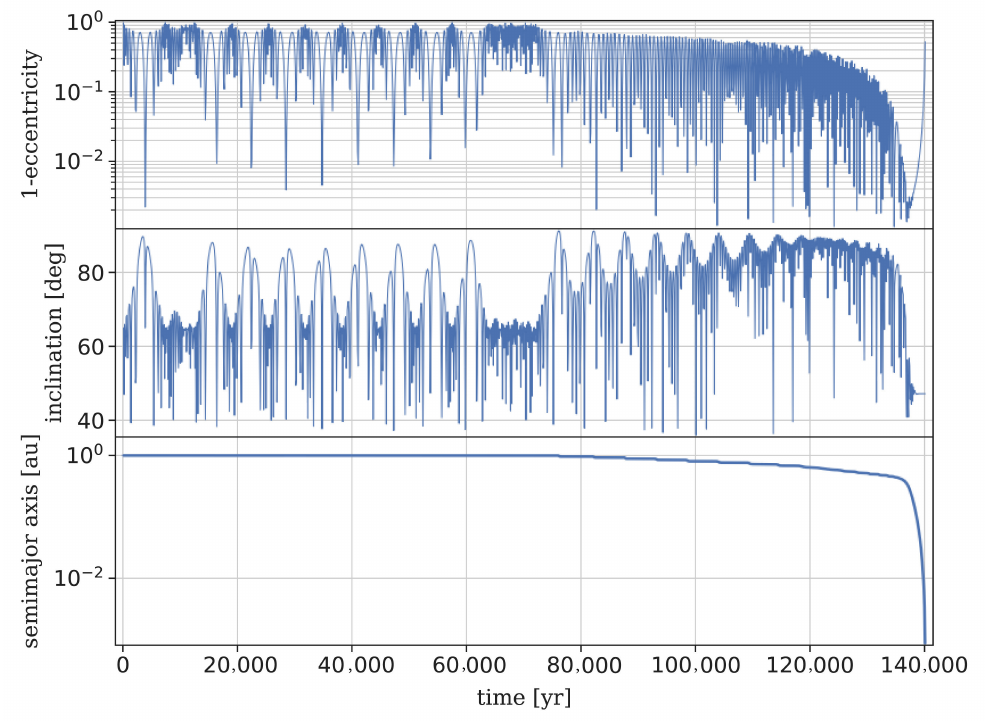
Figure 10. Gravitational-wave merger induced by von Zeipel-Kozai-Lidov evolution in a triple system. Orbital parameters as a function of time for a triple system. Top panel: eccentricity of the inner orbit. Middle panel: inclination of the outer body’s orbit with respect to the inner binary. Bottom panel: semimajor axis of the inner binary. The initial orbital parameters of the triples are: mass of the outer body m 3 = 40M (cid:12) , mass of the inner bodies m 1 = 10M (cid:12) , m 2 = 20M (cid:12) , inner semimajor axis a 1 = 1 au, outer semimajor axis a 2 = 16 au, mutual inclination i mut = 65 ◦ . Evolved with OKINAMI , which solves the orbit-averaged equations of motion in Delaunay coordinates (Trani et al., in